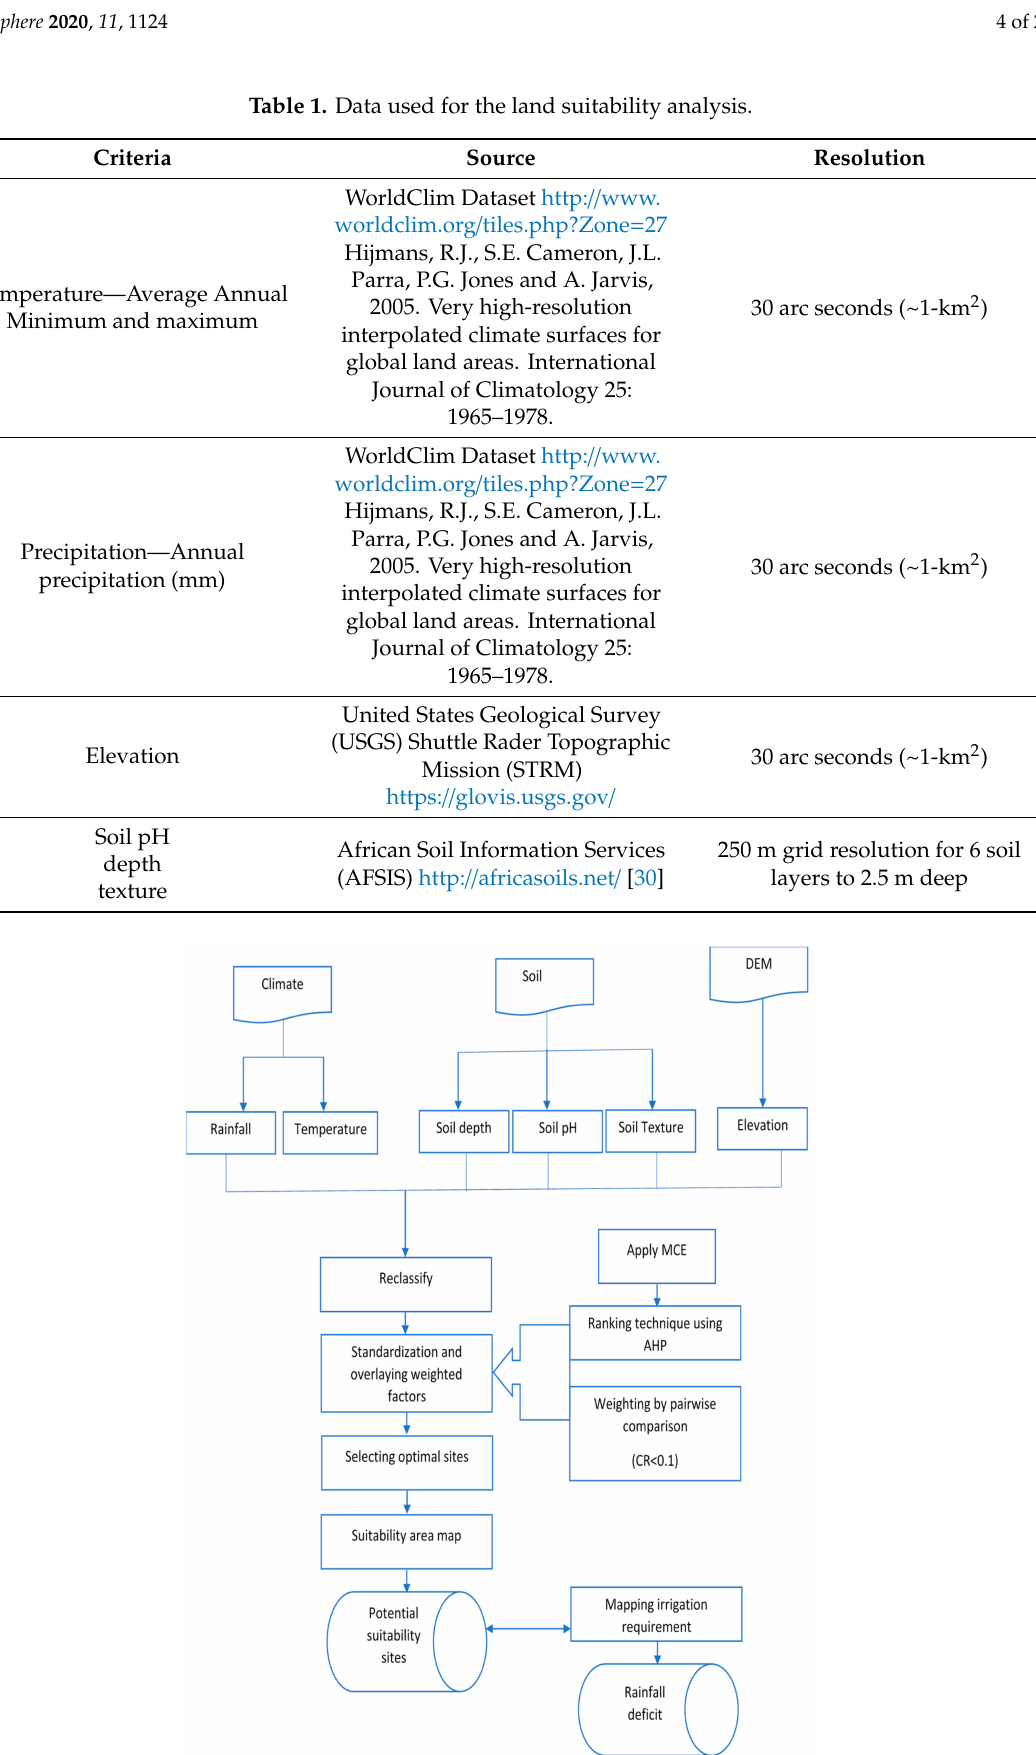
Figure 2. General workflow of procedures for evaluating land areas suitable for alfalfa fodder